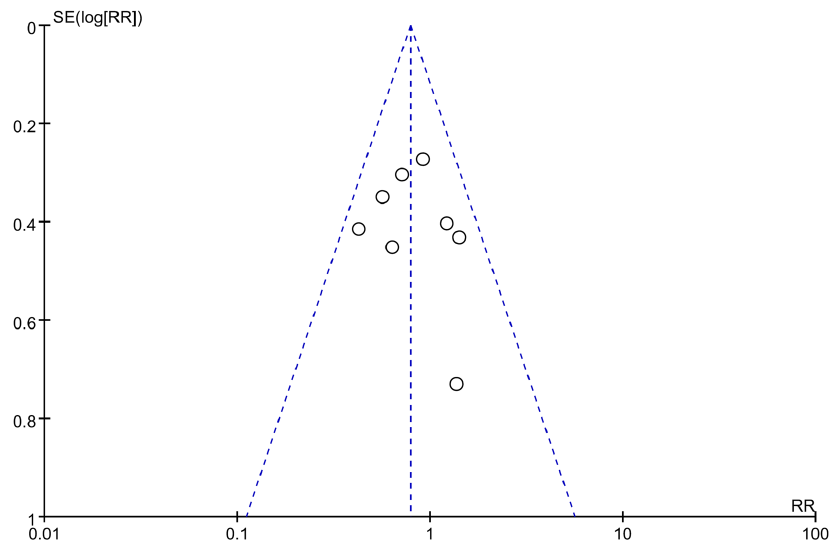
Fig 5. Funnel plot indicating no evidence of heterogeneity between trials for distant metastasis rate. RR values included in the meta-analysis are indicated on the abscissa axis, and the SE (Log OR) values are indicated on the ordinate axis. The impact of publication bias was assessed by observing the